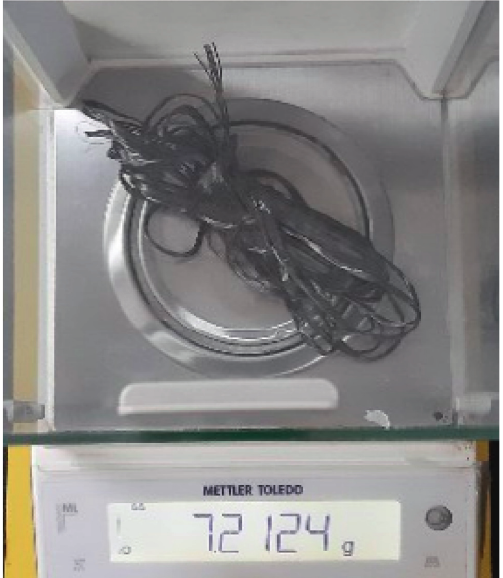
Figure 9: Electronic scale for the calculation of the diameter of the tow carbon fiber.